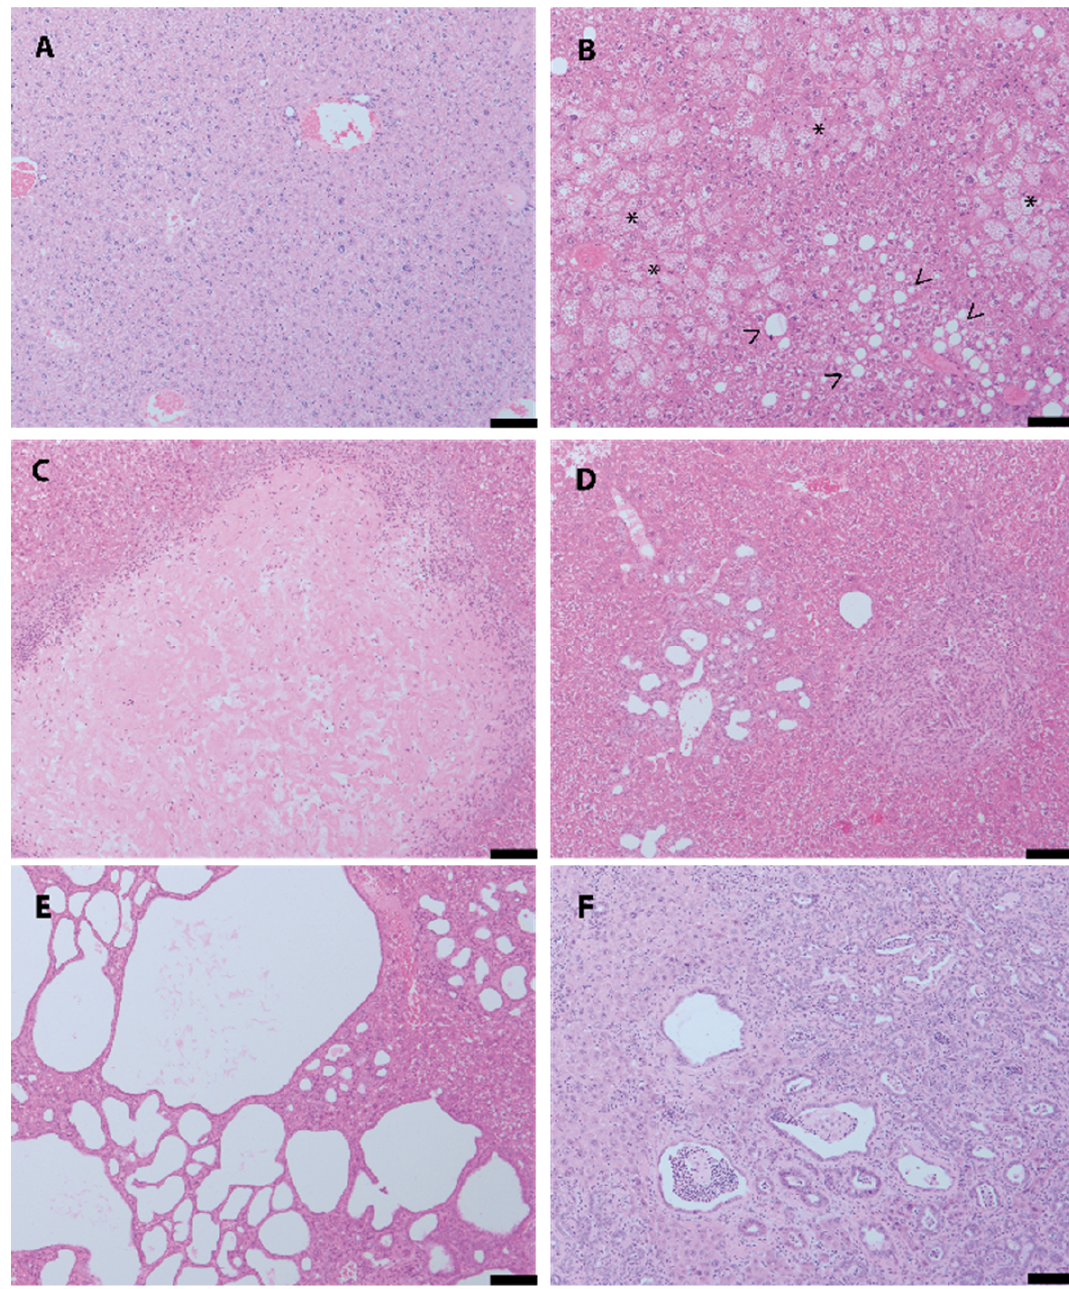
Figure 2. Spectrum of non-neoplastic lesions. ( A ) hepatocellular hyperplasia; ( B ) metabolic changes including macro- / microvesicular steatosis ( < ) and glycogen accumulation (*); ( C ) fibrosis; ( D ) bile duct hyperplasia; ( E , F ) inflammatory bile duct changes including cystic bile duct dilation ( E ) and cholangiofibrosis ( F ). Scale bar: 100 µm.